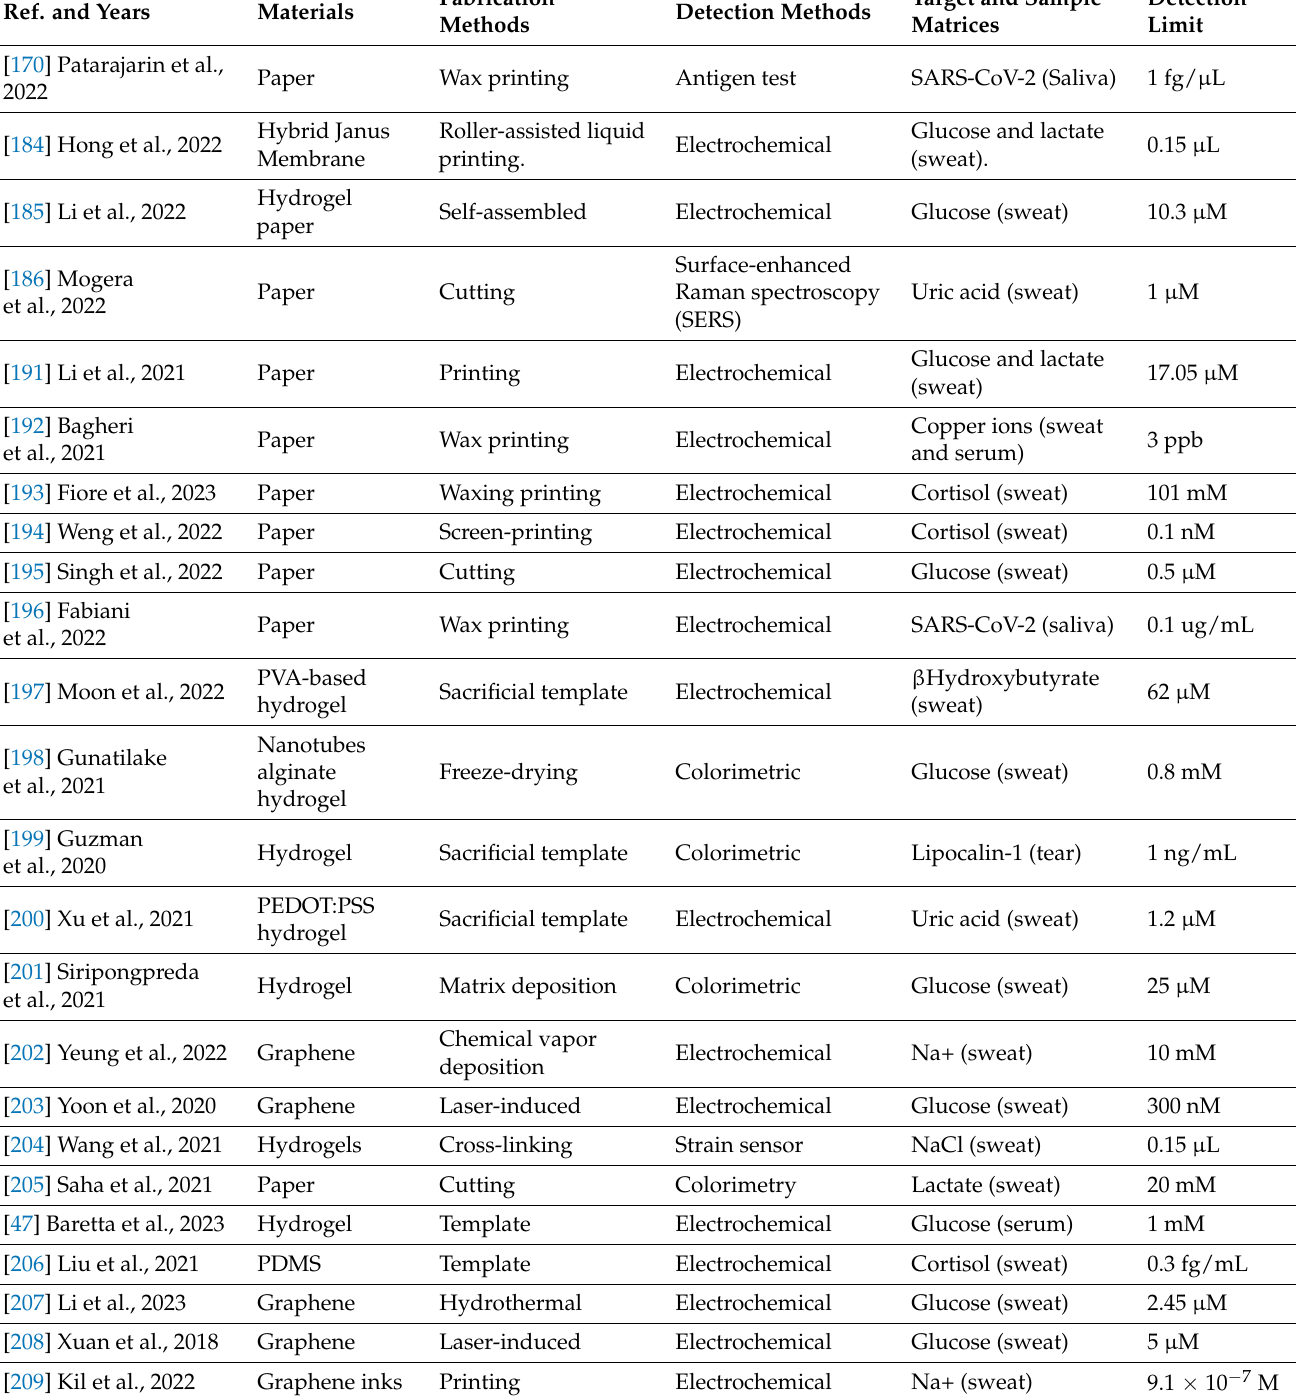
Table 2. Summarizes the porous based microfluidics for detection on body fluid